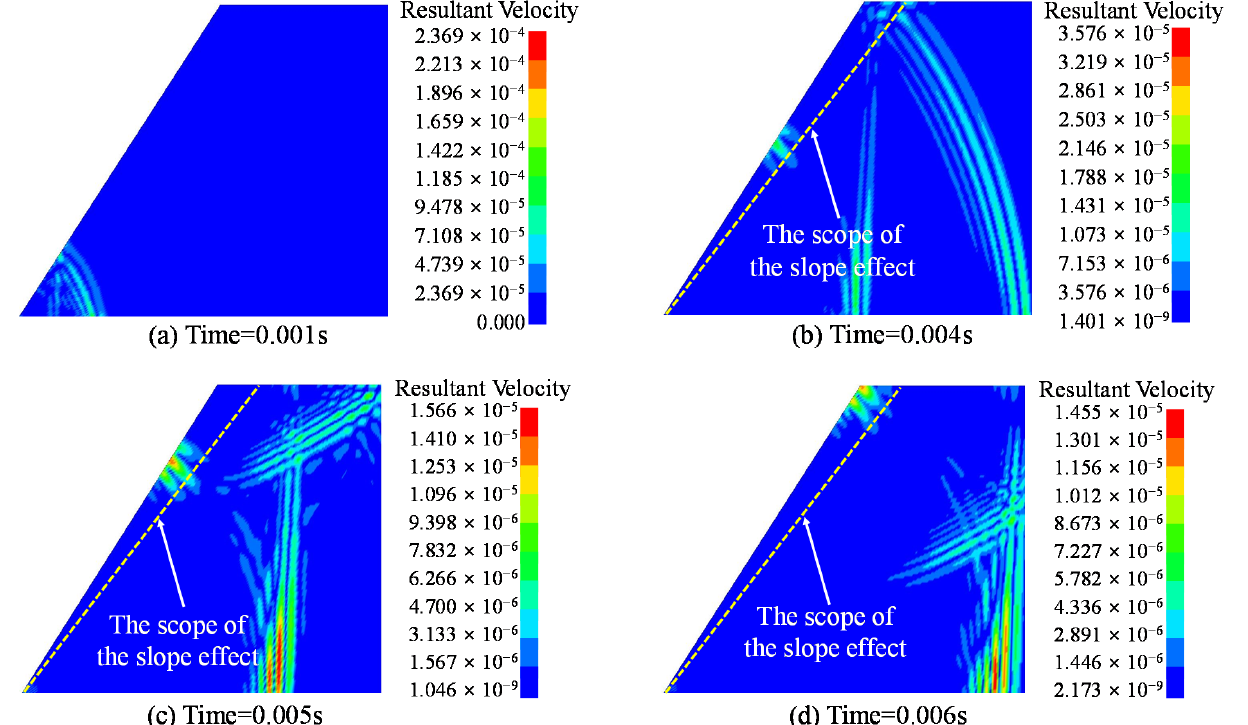
Figure 6. Numerical simulation results of blast vibration velocity of the slope.